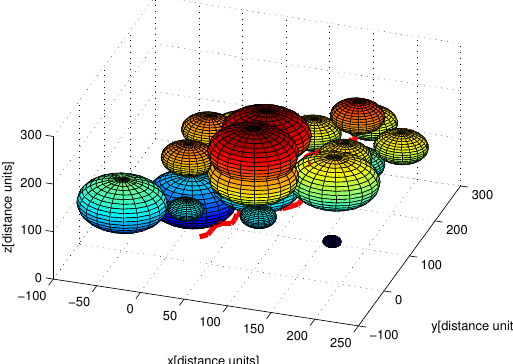
Figure 7. Highly cluttered environments. The path constructed utilizing one MC simulation of the 3D RRT-star planner. The obstacles are shown as spheres. The generated path is depicted with red line segments.